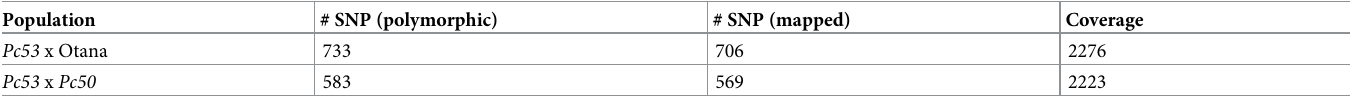
(Table 1). JMP genomics, v. 8.1 (SAS Institute, Cary, NC, 2016) was used to construct genetic Table 1. Number of polymorphic SNPs between parental lines and mapped SNPs in the two oat mapping populations.